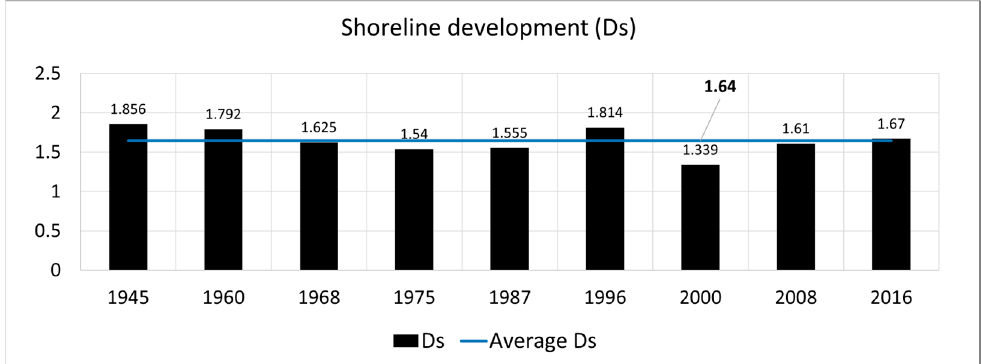
Figure 6. Kotychi Lagoon shoreline development index (Ds) fluctuations during the study period. The blue line represents the average Ds value.